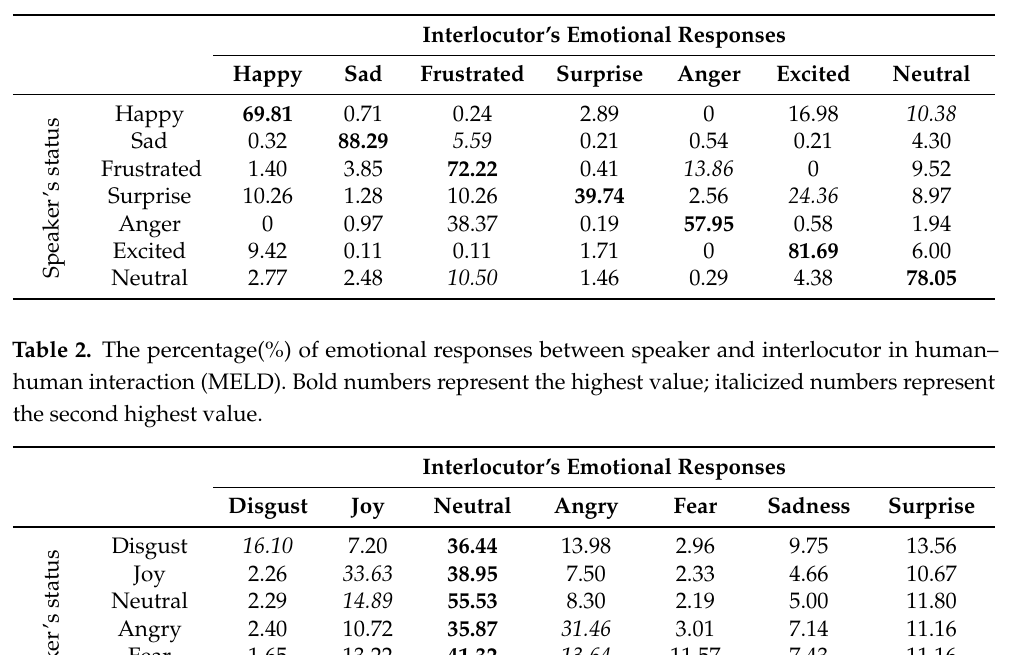
Table 1. The percentage (%) of emotional responses between speaker and interlocutor in human– human interaction (IEMOCAP). Bold numbers represent the highest value; italicized numbers represent the second highest value.